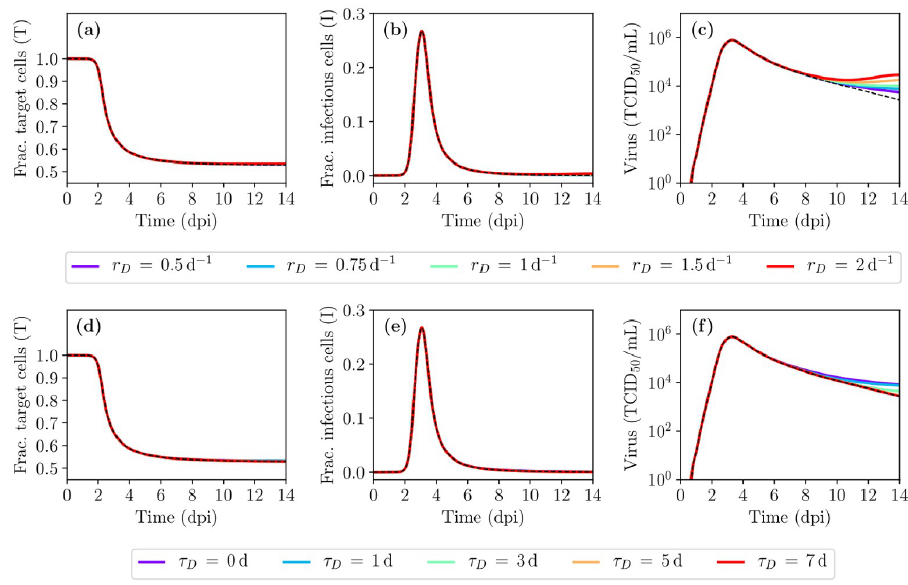
Fig 7. The effect of cellular regeneration on the MM prediction of IAV infection kinetics. The effect of varying (a– c) the regeneration rate ( r D ) or (d–f) the regeneration delay ( τ D ) are shown. Unless varied, τ D = 1 s and r D = 0.75 d − 1